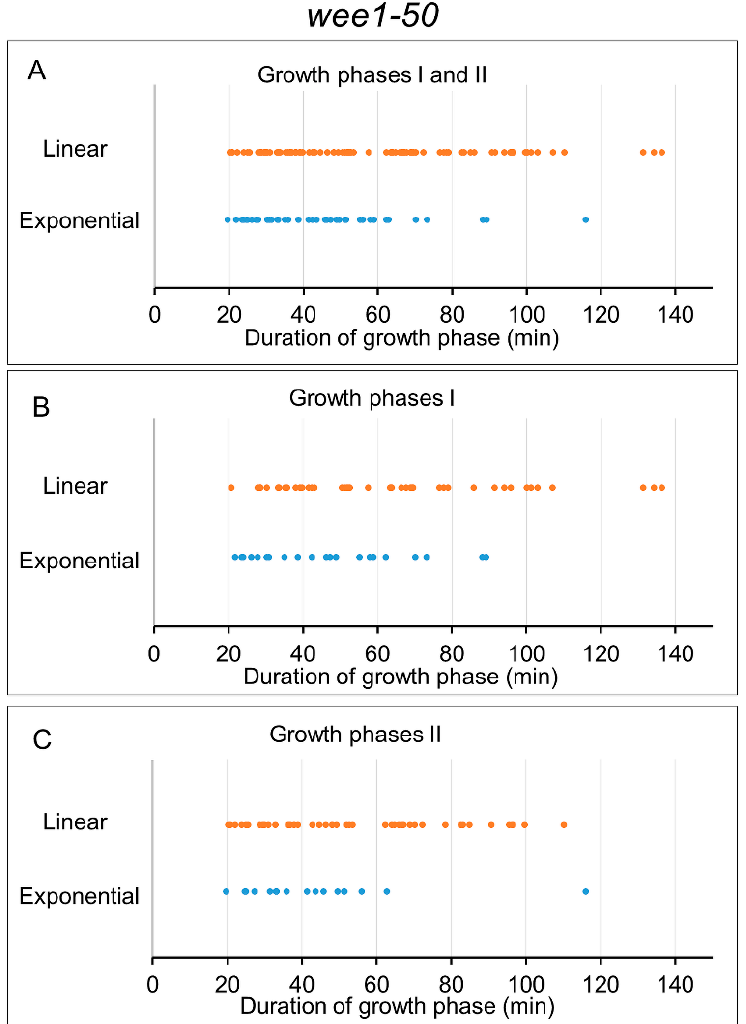
Figure 5. Distribution of the growing segments, examined in the ‘bilinearly’ growing wee1-50 mutant fission yeast cells. The growth phases are separated by the more adequate fitted model (linear or exponential). The symbols represent the growing segments, whose durations are given in minutes. ( A ) All the growth phases (I and II) are shown. ( B ) Only growth phase I is shown. ( C ) Only growth phase II is shown.